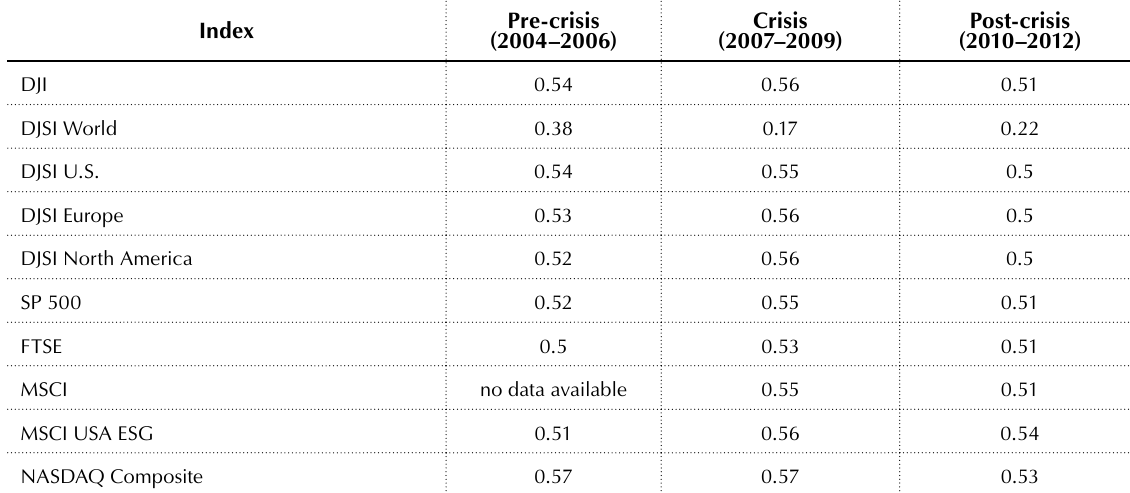
Table 6. Behavior of sustainability and traditional indices during pre-crisis, crisis and post-crisis periods: case of global financial